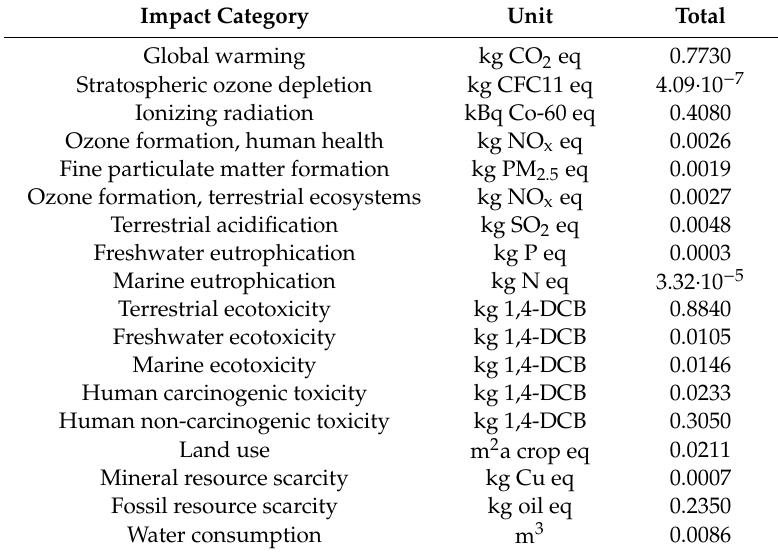
Table 1. Impact category values related to collagen sca ff